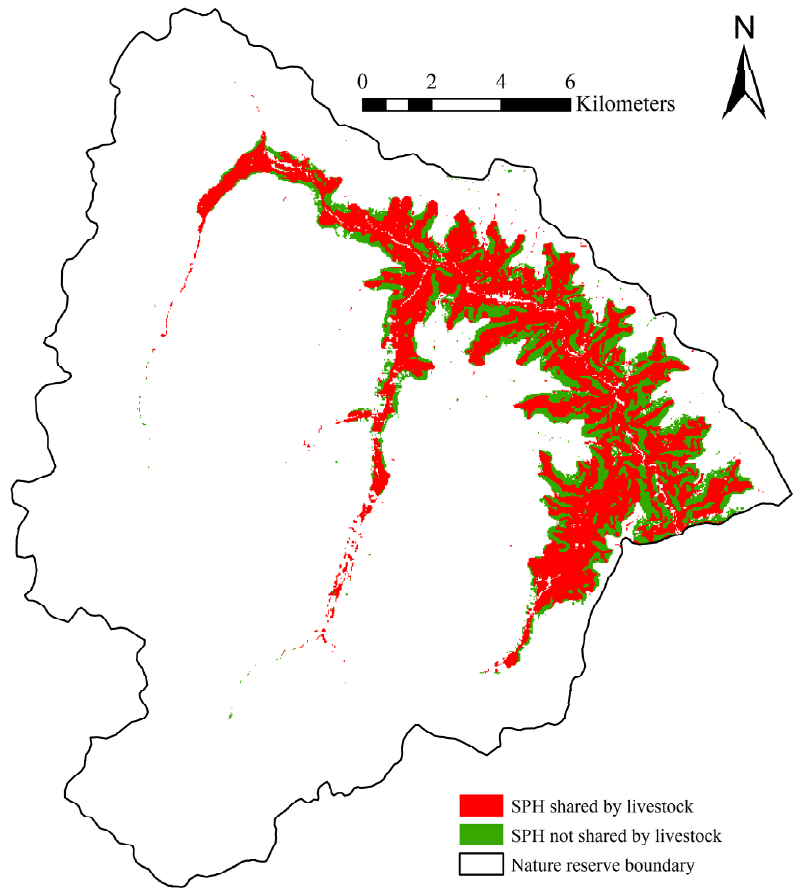
Figure 4. Suitable giant panda habitat shared by livestock (SPH: suitable giant panda habitat).